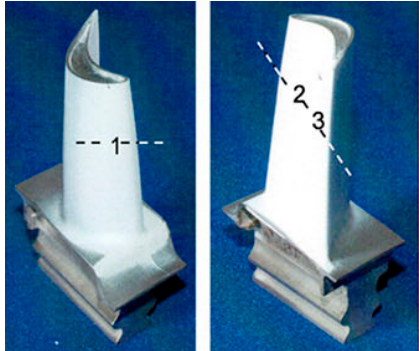
Figure 5. Real application that received an yttria-stabilized zirconia thermal barrier coating (YSZ TBC) - high-pressure turbine blade. Adapted from [26].